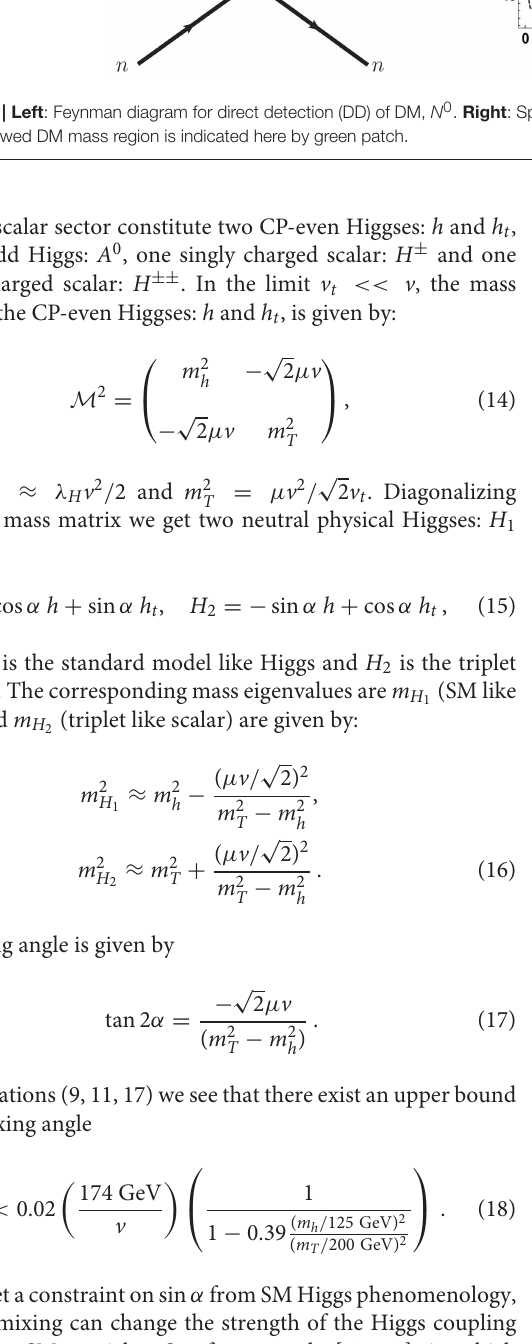
σ SI N plane. Relic −